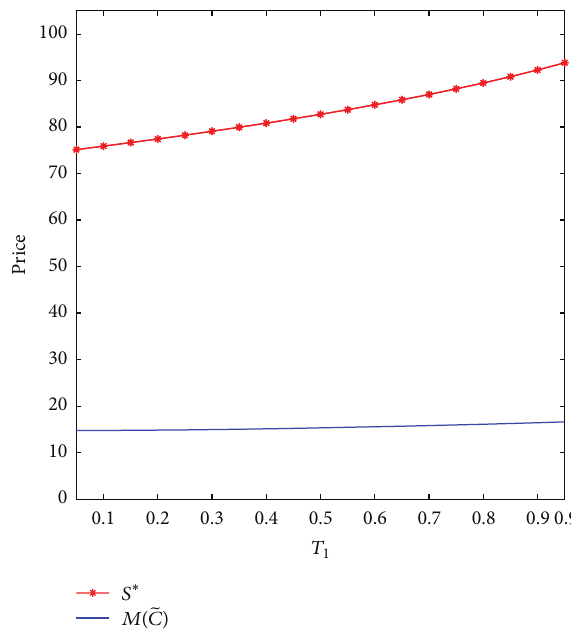
𝑀(̃𝐶) with respect to 𝐾 1 .